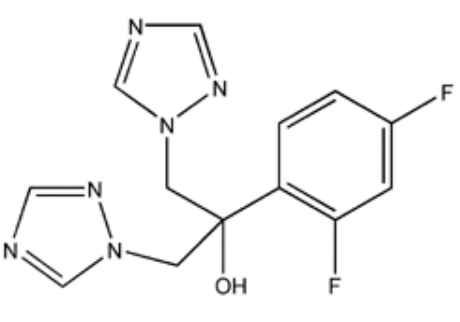
FIGURE 6. Chemical structure of fluconazole (Diflucan).